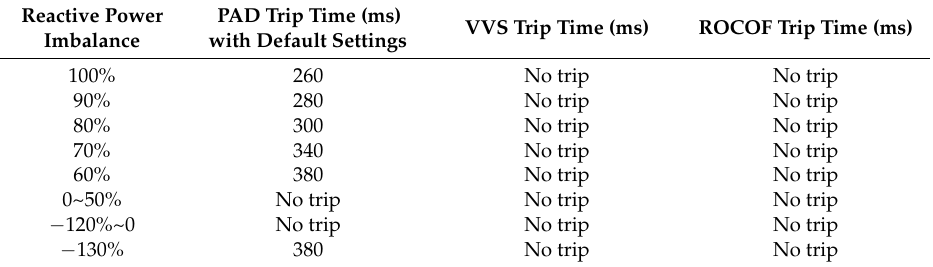
Table 4. Sensitivity performance comparison with default settings under reactive power